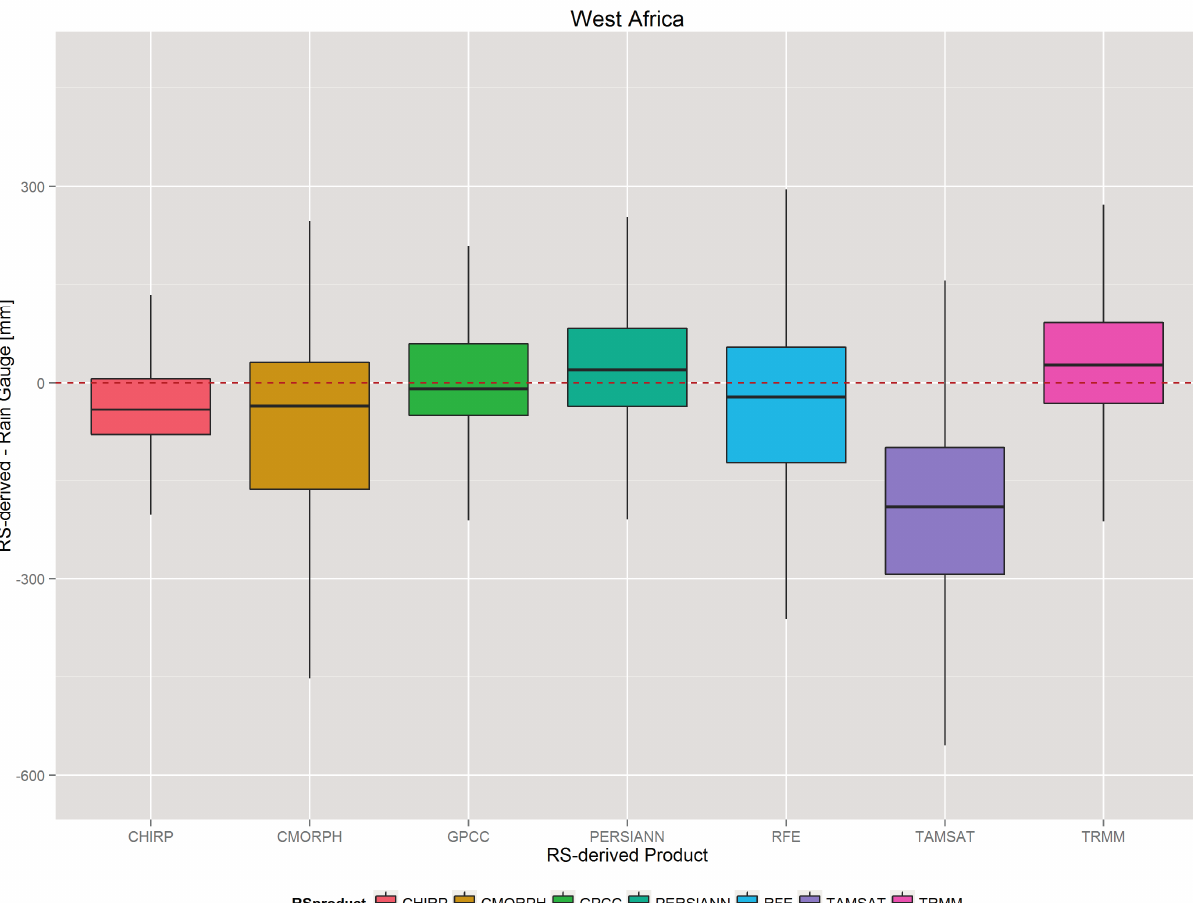
Figure 15. Box-and-Whiskerplot of the difference between downscaled and observed precipitation across West Africa for different RS